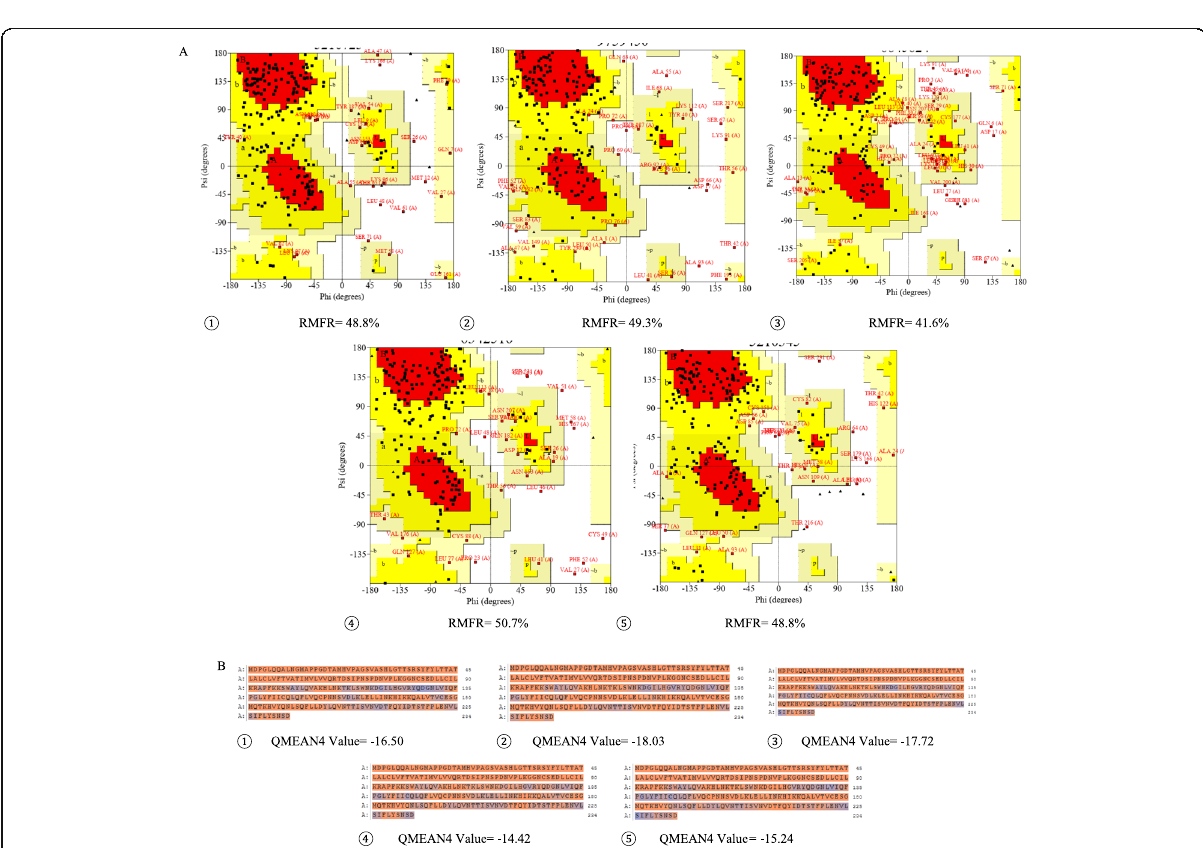
Fig. 6 Quality of ① model 1, ② model 2, ③ model 3, ④ model 4, and ⑤ model 5 predicted by I TASSER showing a the Ramachandran plots showing the percentage of the residues in most favoured regions (RMFR) and b QMEAN showing the sequence coloured by local quality with the colour gradient ranges from orange (low quality) to blue (high quality) and QMEAN4